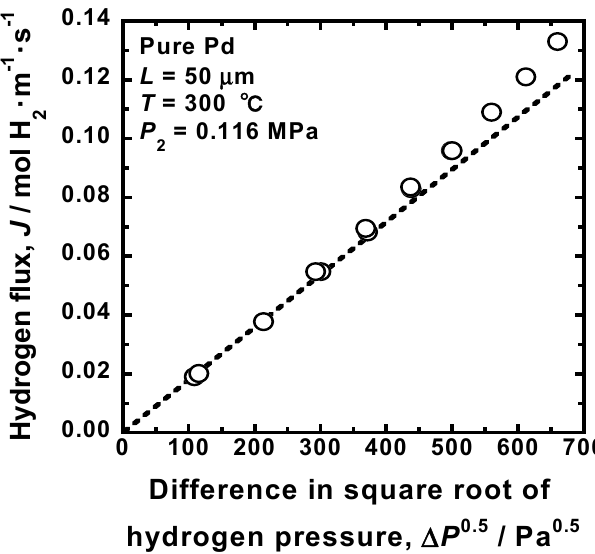
Figure 4. Change in the hydrogen flux through pure Pd membrane at 300 ◦ C as a function of the di ff erence in the square root of hydrogen pressures at the feed and permeation sides [15].